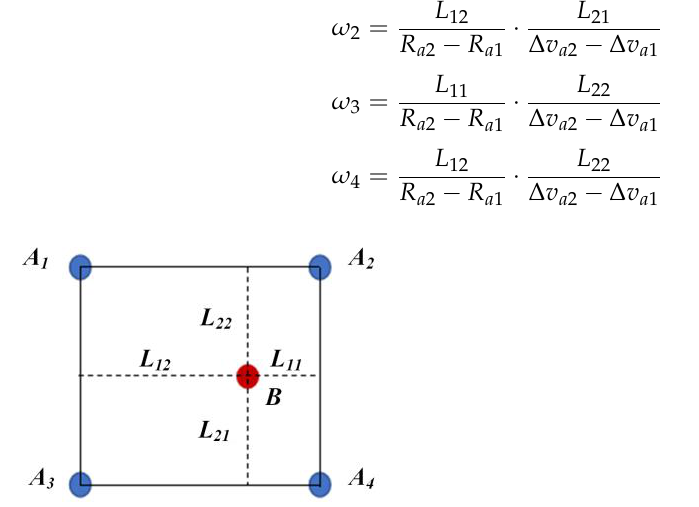
Figure 5. CCM for two-dimensional ISSD.